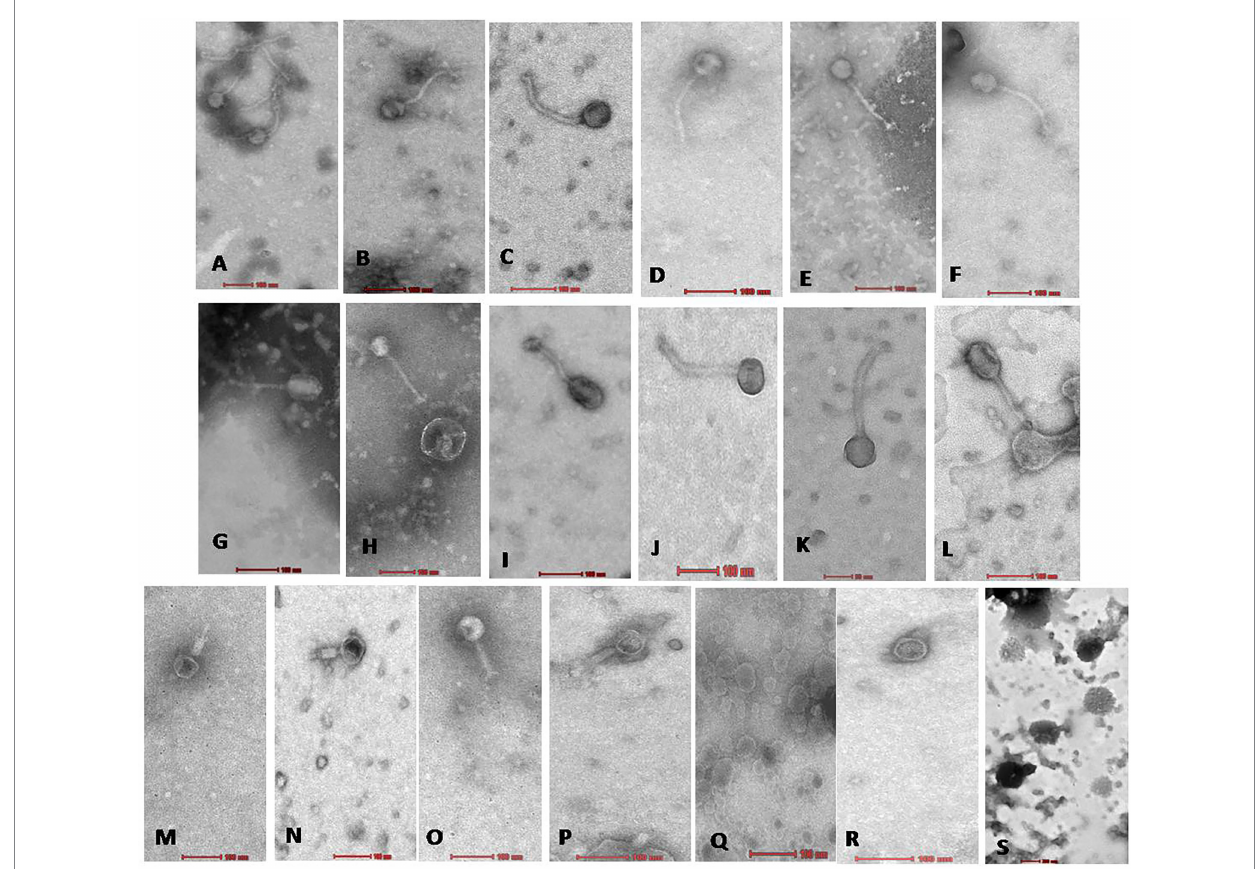
FIGURE 3 Electron micrograph of all 19 Xoophages with head and tail morphology belonging to families Siphoviridae (A–L) ; Myoviridae (M–P) ; Podoviridae (Q,R) ; and Unclassified (S) . From (A − S) , all 19 phages are as follows A : NR02; B : NR04; C : NR07; D : NR08; E : NR09; F : NR10; G : NR11; H : NR12; I : NR13; J : NR16; K : NR17; L : NR18; M : NR01; N : NR03; O : NR06; P : NR15; Q : NR05; R : NR19; S :